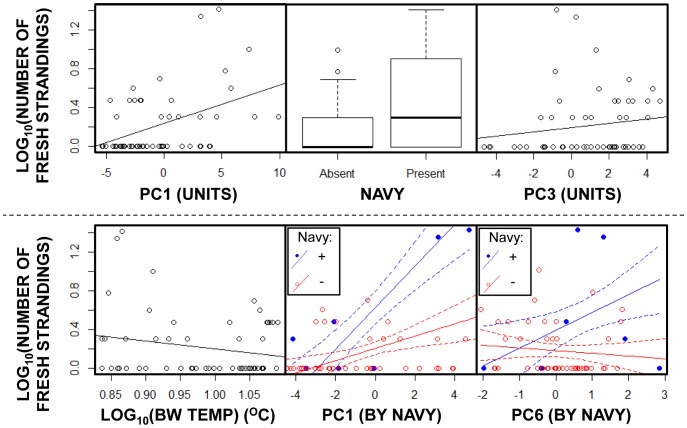
Important model factors for the rate of Danish west coast fresh porpoise strandings, 2003–2008.Specifically, Log10 fresh harbour porpoise strandings correlated with PC1, navy presence, PC3, and BW Temp (log °C), as well as the interactions between Navy presence and both PC1 and PC6 (in order of inclusion into the model). For BW Temp, PC1, and PC3 the data is presented with linear regression lines; for the navy presence, the bold lines represent median values, the boxes are 25th to 75th percentiles and the whiskers extend to the most extreme data within 1.5 IQR (interquartile range) of these lower and upper quartiles. Outliers are represented by points. For PC1 and PC3 by navy state, the data is presented with linear regression lines (continuous) and 95% confidence intervals (dotted) separately for periods where the navy was present (blue) and absent (red). PC1, PC3, and PC6 are products of the PCA and are, thus, unit-less.